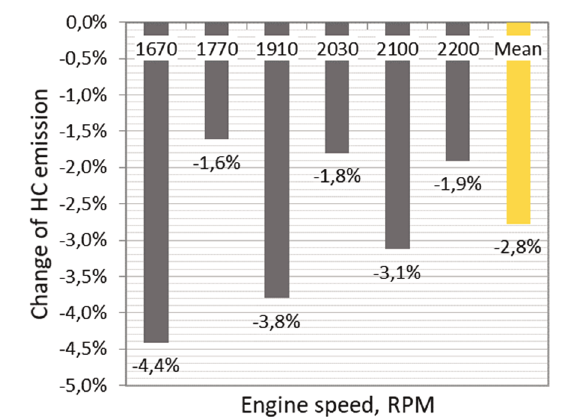
Fig. 12. Differences in HC emission power between engines with constant and variable ignition advance angle